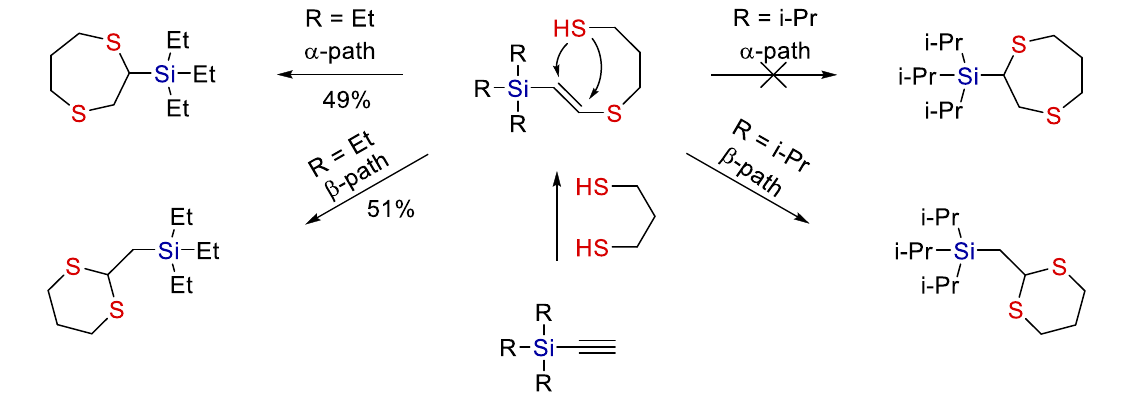
Figure 2. A scheme of ionic thiol-ene addition to ethynylsilane. Adopted from Ref. [15].